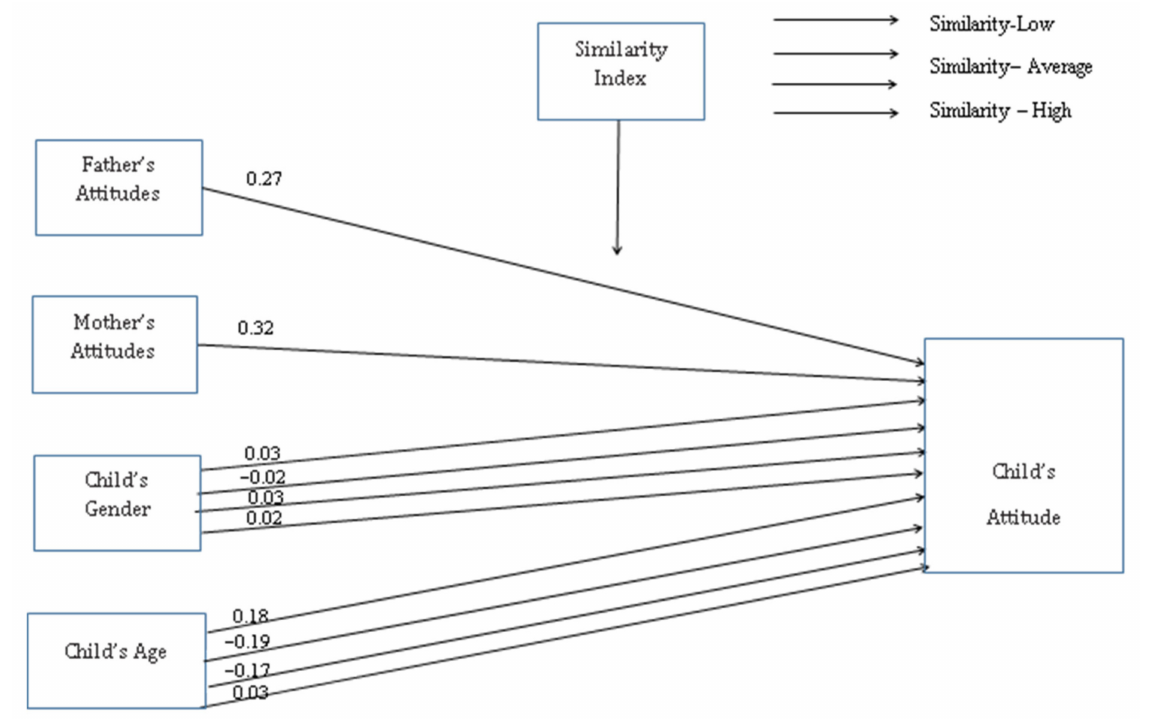
Figure 4. Attitudes toward students with